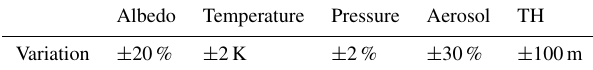
Table 2. List of the parameters used for the sensitivity studies and respective values of the variations, i.e., their standard deviation, cor- responding to their estimated